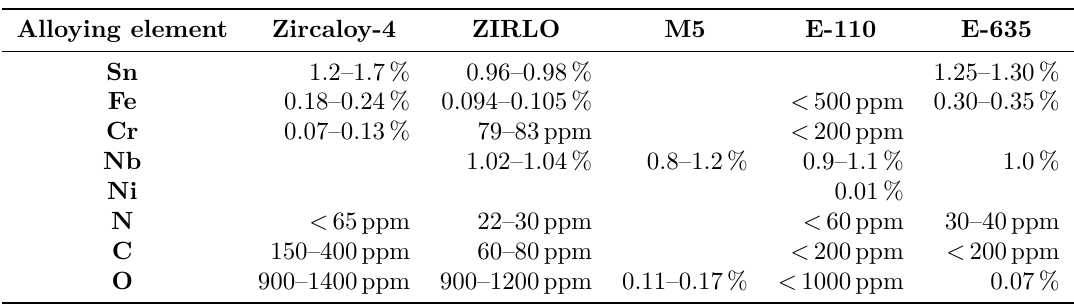
Table 1. Composition of zirconium-based alloys widely used around the world in PWRs as materials for cladding tubes fabrication [7].